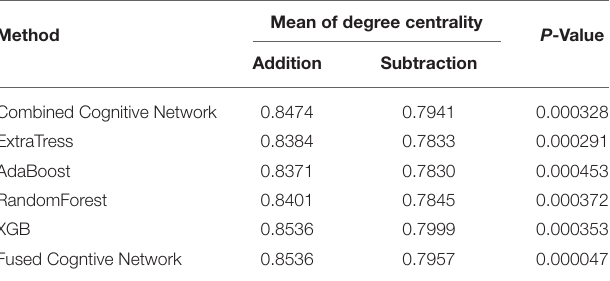
TABLE 3 | Performance of each method in discriminating cognitive